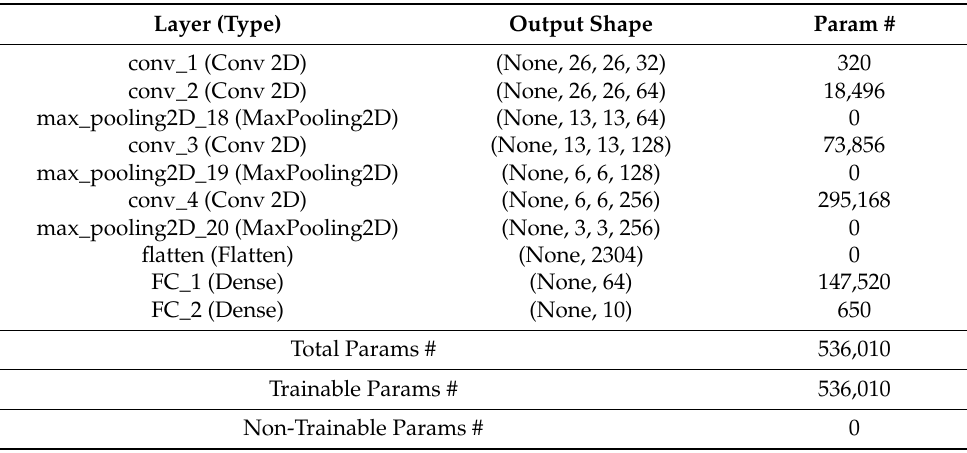
Figure 6. Proposed CNN model for character recognition. Table 1. Details of the proposed model.